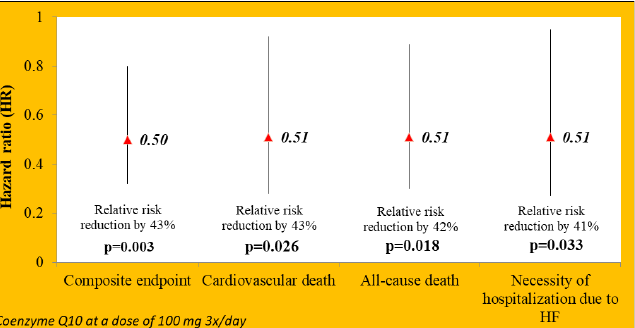
Figure 8. Results of Q-SYMBIO study: the influence of coenzyme Q10 supplementation on the prognosis of patients with HF. Based on information from Mortensen S. et al. [63]. HR (hazard ratio) — risk ratio; HF — heart failure .